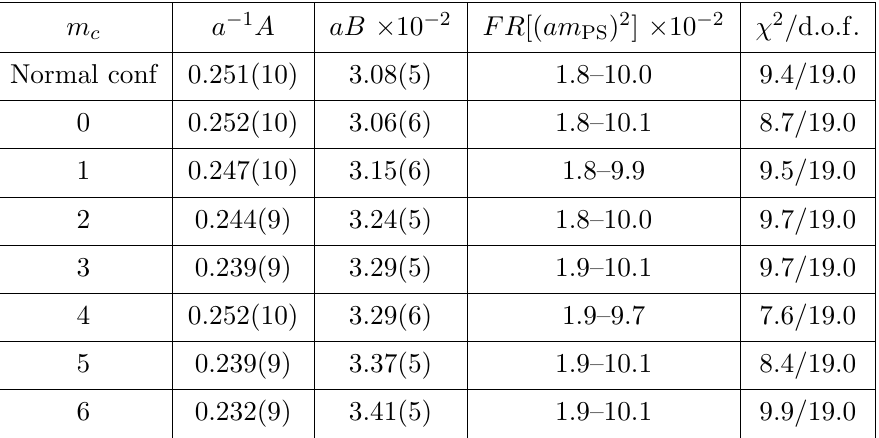
Table 16 . The (cid:12)tting results of the slope a (cid:0) 1 A and intercept aB obtained by (cid:12)tting function (6.1).